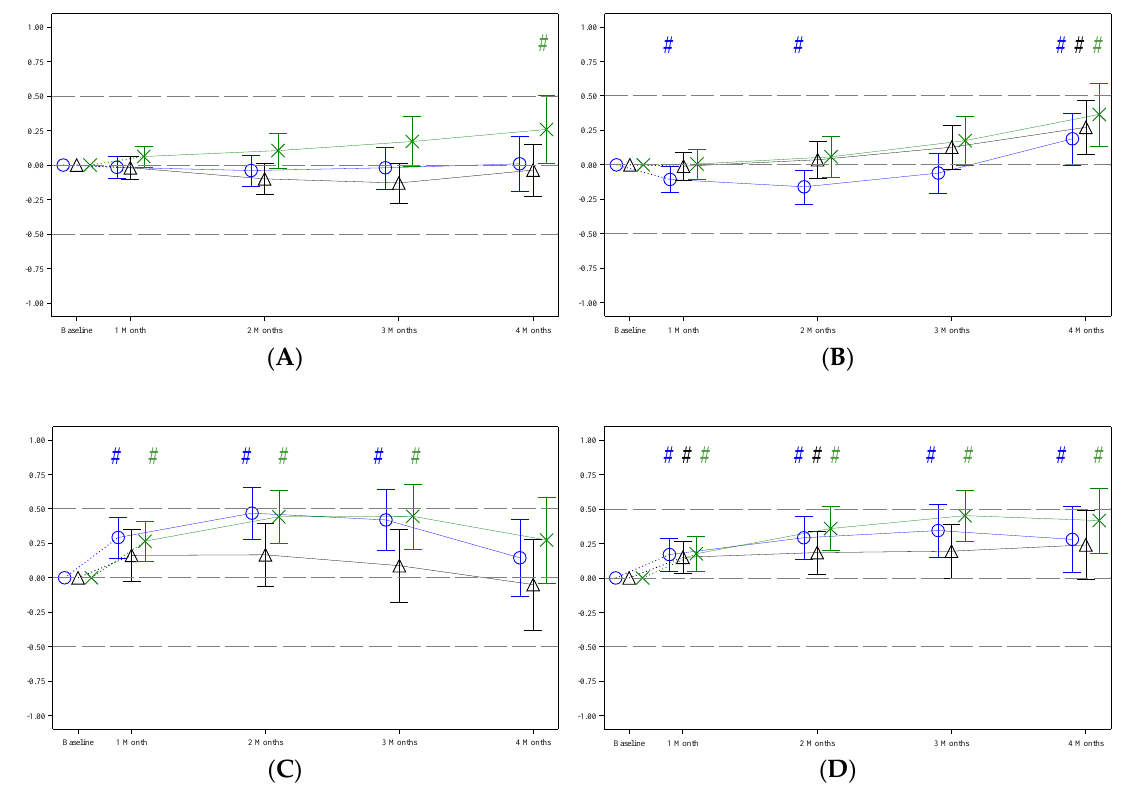
Figure 4. Estimated mean (95% CI) z -scores during the intervention period for pHF1.8 (blue), pHF2.0 (black) and pHF2.27 (green): ( A ) weight-for-age z -score; ( B ) length-for-age z -score; ( C ) weight-for-length z -score; ( D ) head circumference-for-age z -score. Post baseline estimates are derived for the largest study site, 1:1 ratio for boys and girls and a respective baseline z -score value of zero as fixed e ff ects. For completeness, the observed (raw) z -scores are included in Supplementary Table S4. # = Statistically significant di ff erence between a formula group and WHO Child Growth